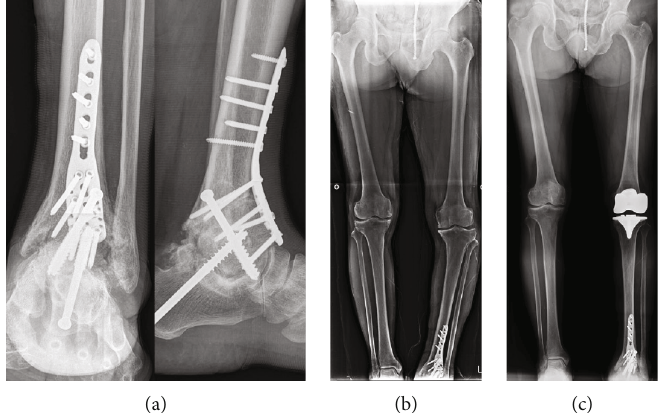
Figure 4: (a, b) The patient underwent tibiotalocalcaneal arthrodesis surgery. (c) Six months after tibiotalocalcaneal arthrodesis surgery, he underwent left total knee arthroplasty (TKA). A standing AP radiograph of the bilateral lower extremities revealed a 1.1 ° left HKA